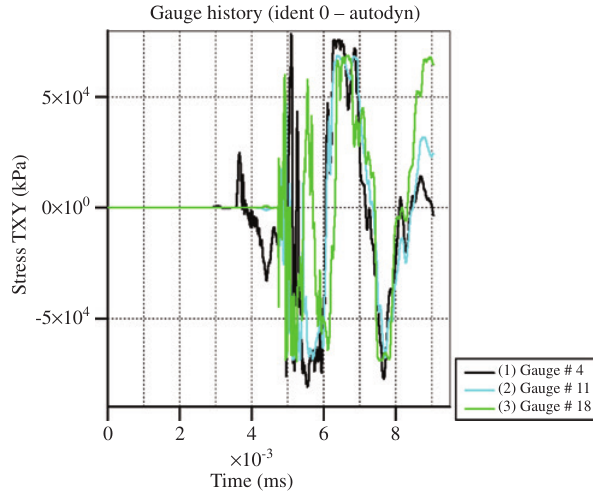
Figure 15: Stress TXY time curve of points 4, 11, and